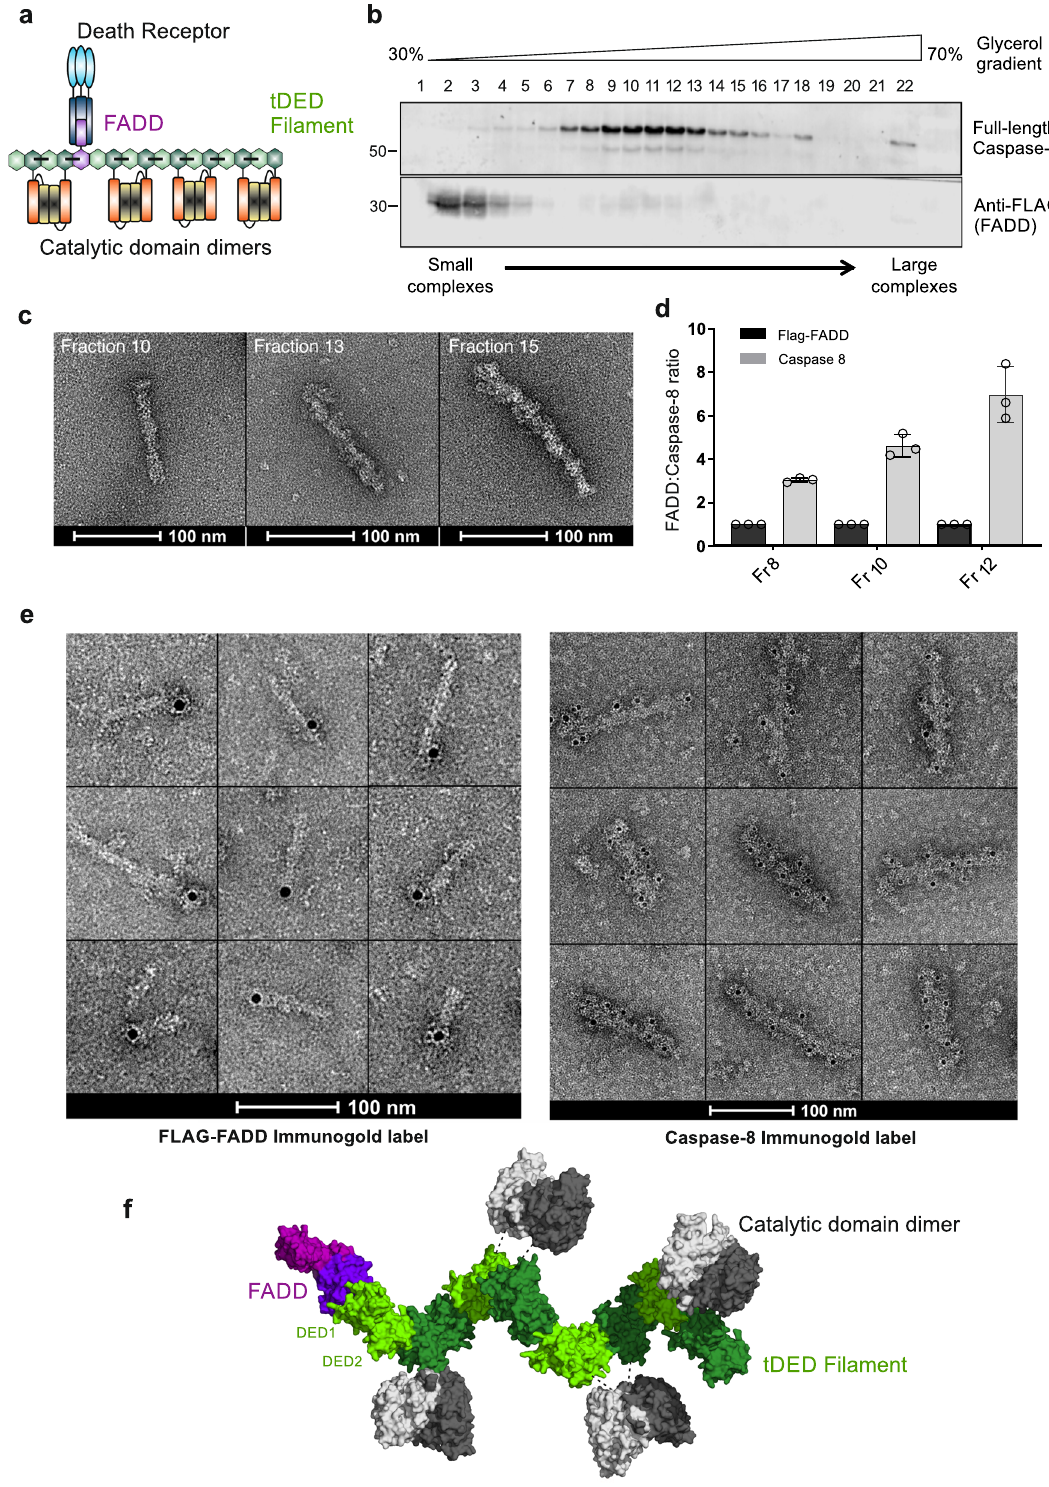
Fig. 1 Caspase-8 fi lament formation is nucleated by FADD. a Schematic representation of the architecture of DISC. b Western blot analysis of Glycerol Density Gradient puri fi cation of soluble Flag-FADD:Caspase-8 complexes. Western blots are representative of 3 independent experiments. c Negative- stain EM of FADD:Caspase-8 fi laments puri fi ed from different gradient fractions (Fractions 10, 13 and 15). Micrographs are representative of 3 independent experiments. d Label-free quantitative mass spectrometry determination of FADD:Caspase-8 ratio in Glycerol Density Gradient fractions (Graph shows Mean± SD, n = 3 technical repeats; from a representative experiment of 3 biologically independent experiments). e Immuno-gold labeling of FLAG-tag and Caspase-8 p18 subunit in puri fi ed fi lament complexes from Fraction 10 within the peak visualized by EM. Micrographs are representative of 3 independent experiments. f Structural model of FADD:Caspase-8 tDED single-chain complex. Source data are provided as a Source Data fi le.